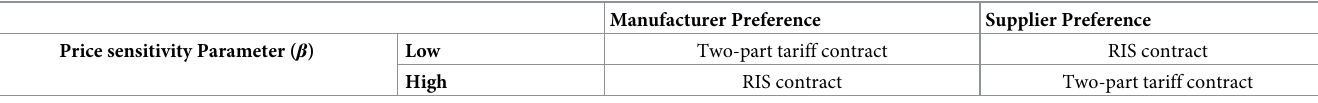
Table 4. Contract preferences of manufacturer and supplier at low and high value of β